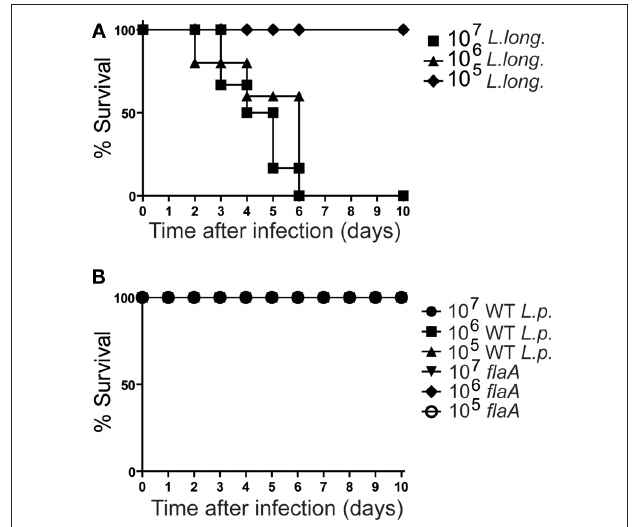
Figure 4 | Legionella longbeachae , but not flaA mutants of L. pneumophila, is lethal for mice . (A) C57BL/6 mice were inoculated with 10 5 (diamonds); 10 6 (triangles); or 10 7 (squares) L. longbeachae ( L. long. ) per mouse and the survival was monitored over a period of 10 days. (B) C57BL/6 mice were inoculated 10 5 , 10 6 , or 10 7 CFUs of wild-type Legionella pneumophila ( WT L.p. ) or with flagellin mutants L. pneumophila ( flaA ). The survival was monitored over a period of 10 days. Ten mice were used per each group. Data are representative of those found in four independent